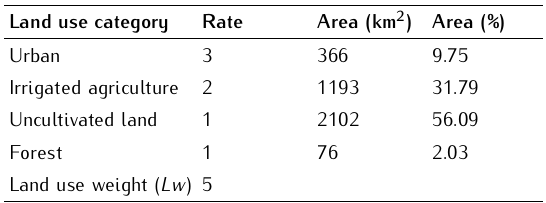
Table 5. Land use categories for the study area and the weights of the parameters [47].